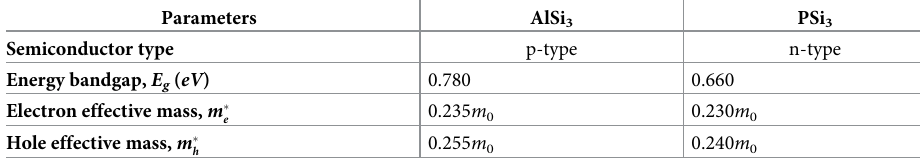
Table 1. Electronic properties of uniformly doped silicene